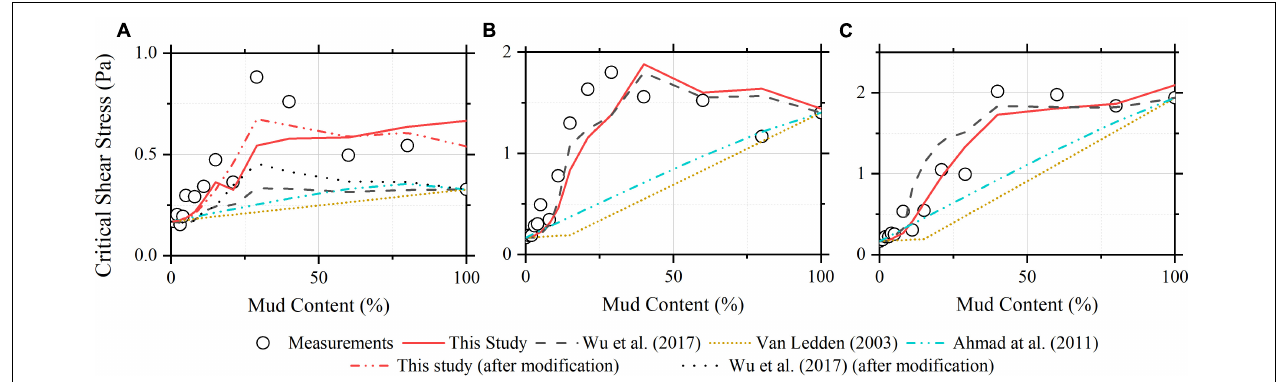
FIGURE 7 | The calculated vs. measured critical shear stresses in the case of Smith et al. (2015): (A) the mixtures of sand and kaolinite; (B) the mixtures of sand and mixed clay; and (C) the mixtures of sand and natural mud.